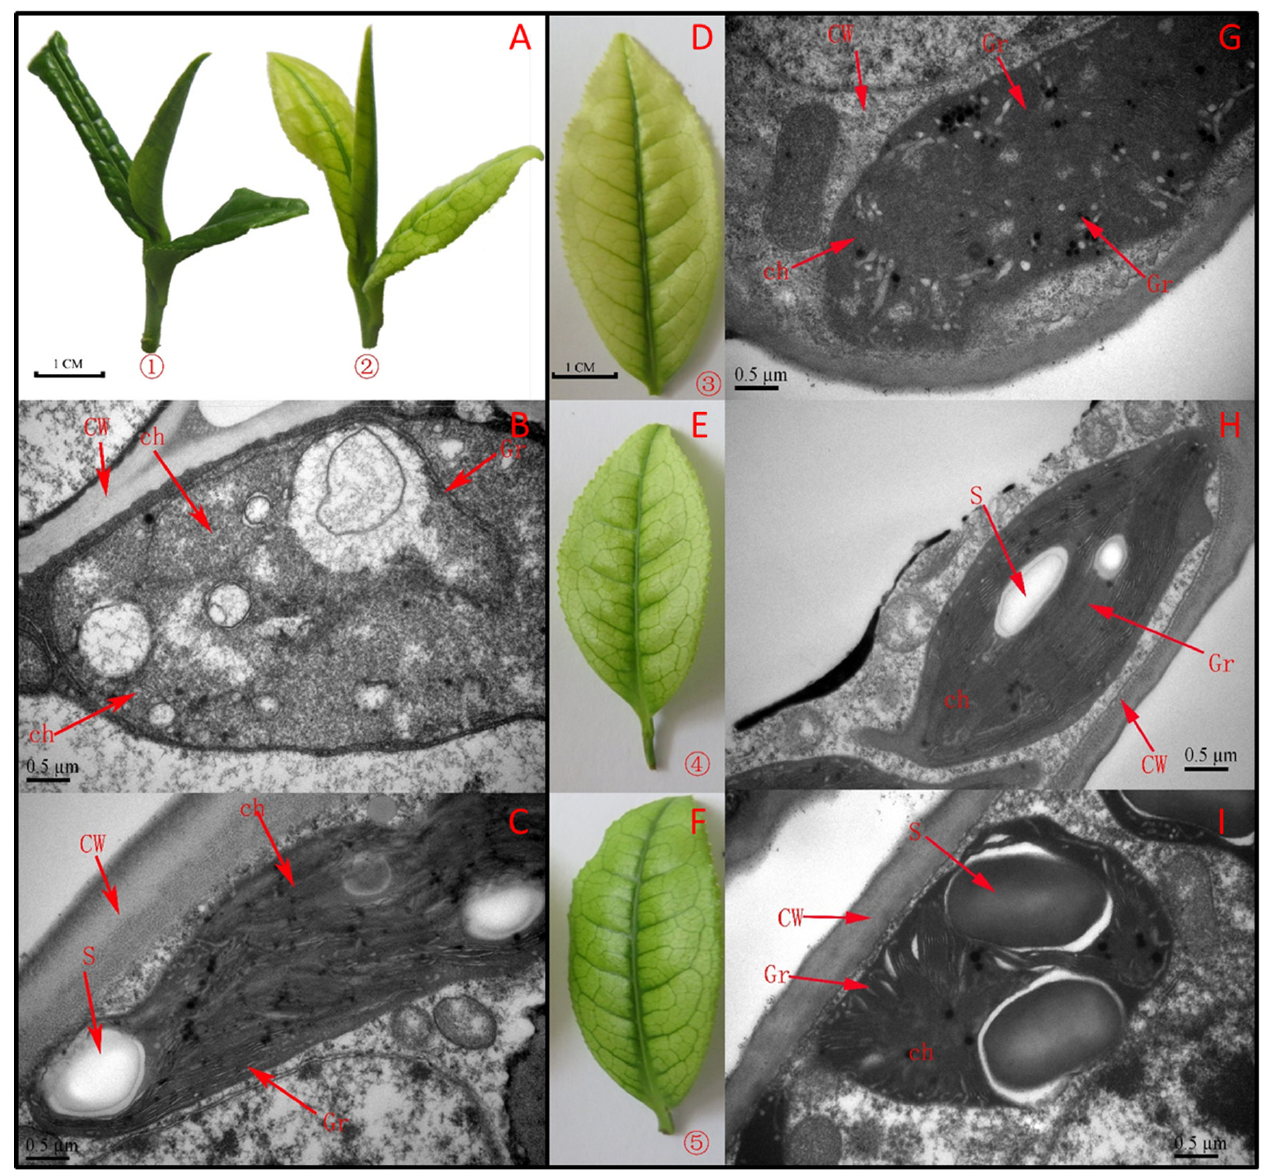
Figure 1. Phenotype ( A , D – F ) and ultrastructure ( B , C , G – I ) of ‘Baiye 1 ′ shoots cultivated for 30 days at 25 °C ( A ① , C ) or 15 °C ( A ② , B ), and for 0 ( D , G ), 3 ( E , H ) and 6 ( F , I ) days after starting greening. Note: CW, cell wall; Gr, grana; Ch, chloroplast; S, starch grains. Table 1. Contents of main catechins, chlorophylls and carotenoids in albino and green leaves of ‘Baiye 1 ′ tea at the indicated time points under greening process obtained by HPLC-DAD (except total polyphenols). Different letters (a, b, c, d, e) indicate significantly different values between time points at p < 0.01 level ( n = 6). NG: normal green leaf, AM: albino mutant leaf, T0: 0 day after starting greening, T1: 3 days after starting greening, T2: 6 days after starting greening. NG AM T0 T1 T2